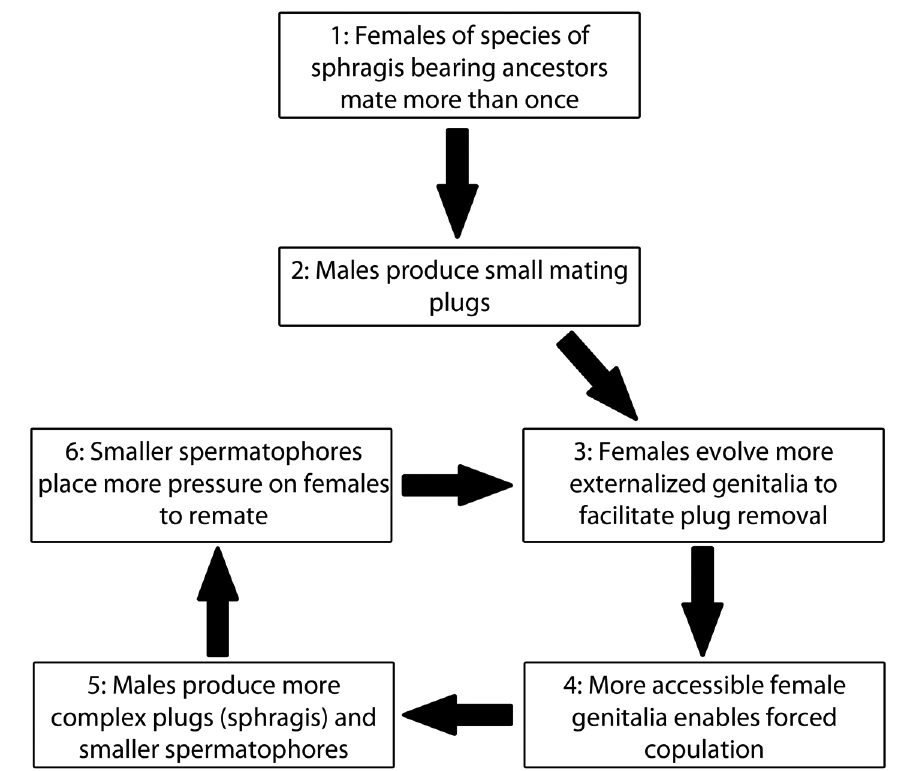
Figure 35. Schematic of the possible process of evolution of the sphragis in butterflies. This assumes a selective landscape where females benefit materially from polyandry and males are continually improving plug-removing